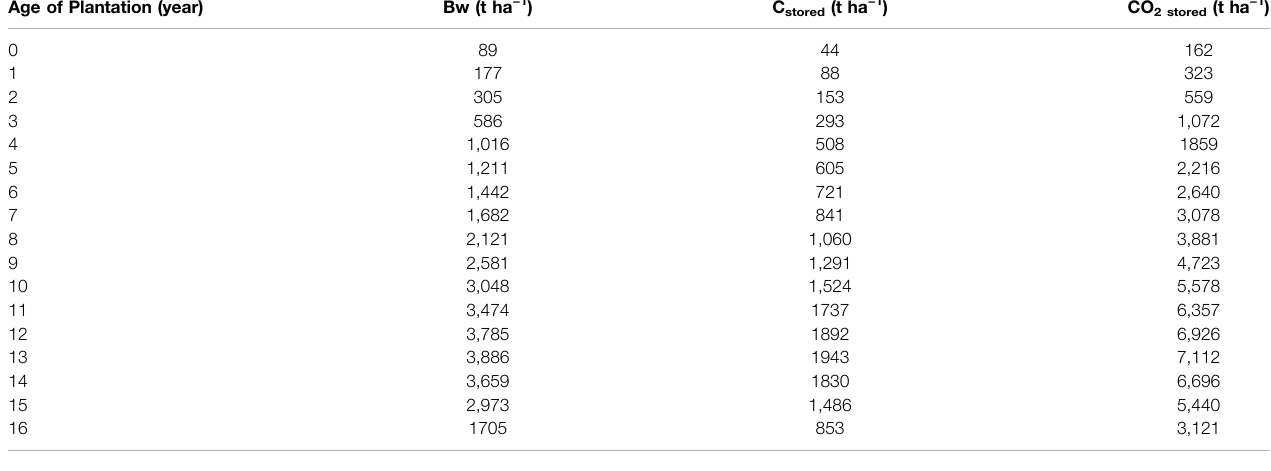
TABLE 2 | Gross above ground biomass (Bw), amount of carbon and of carbon dioxide stored in the above ground biomass (C stored and CO 2 stored ). Age of Plantation (year)